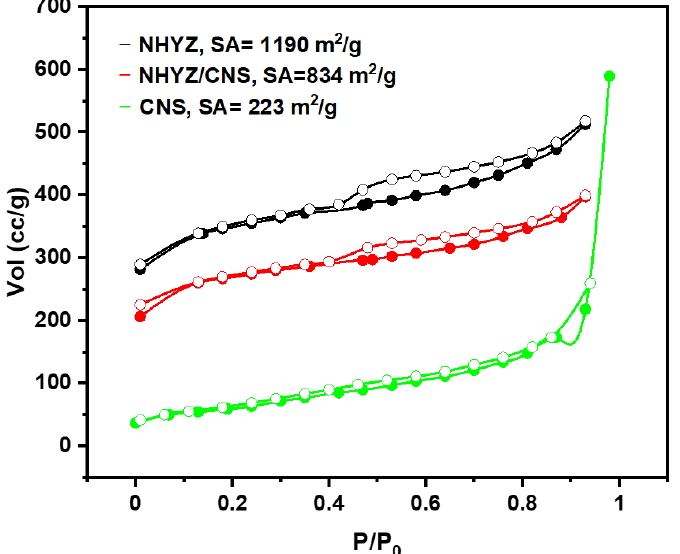
Figure 2. EDS analysis of the NHYZ / CNS catalyst, scale bar = 20 µ m.